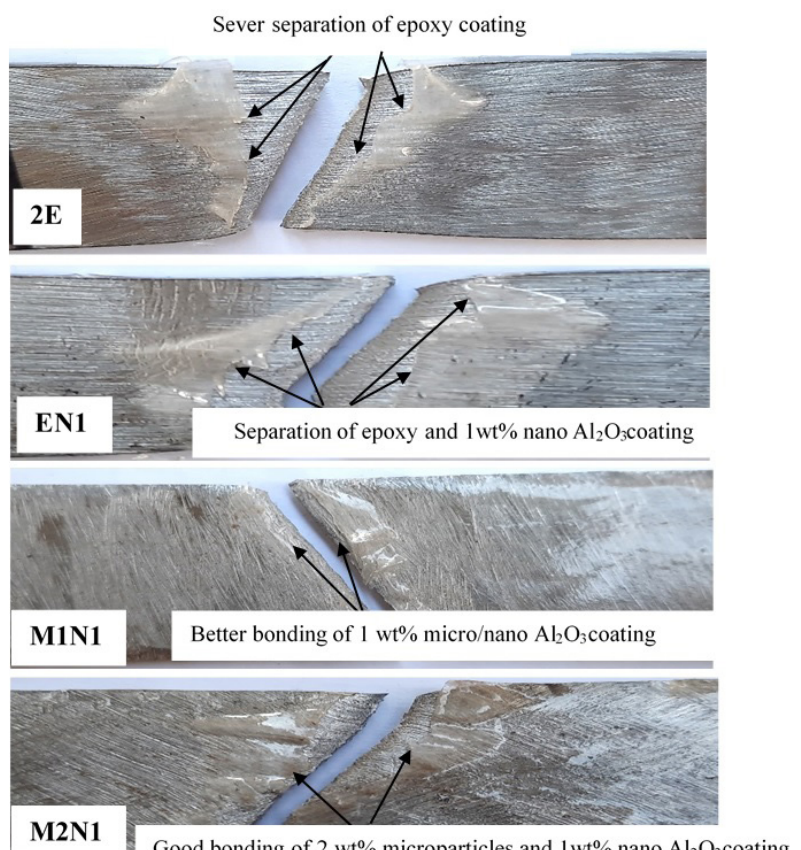
O particles after being subjected to 2 3